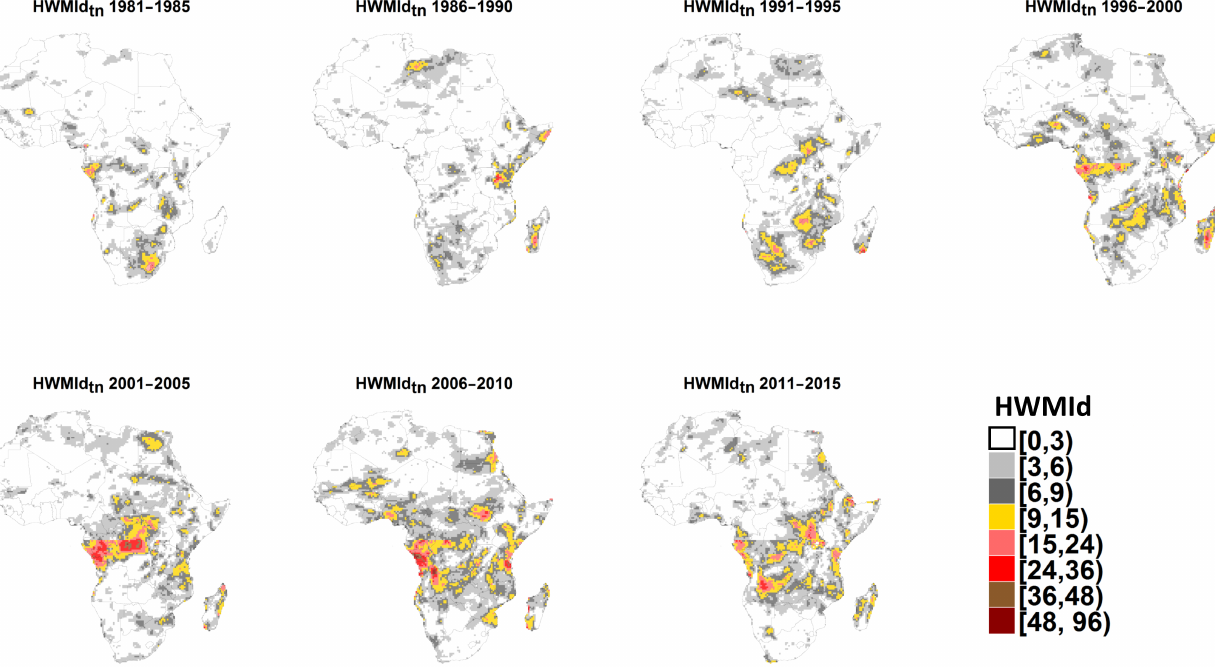
Figure 5. As Fig. 4 but applied to minimum temperature (HWMId tn